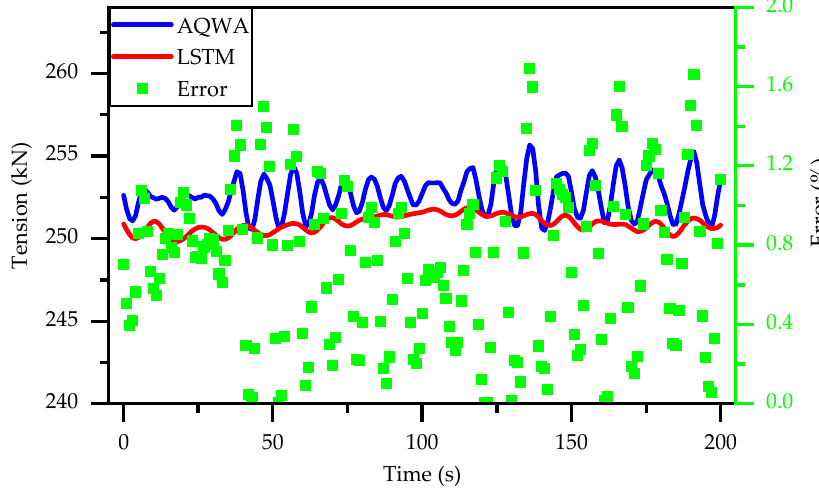
Figure 9. Error analysis of AD7 Mooring Line 7.